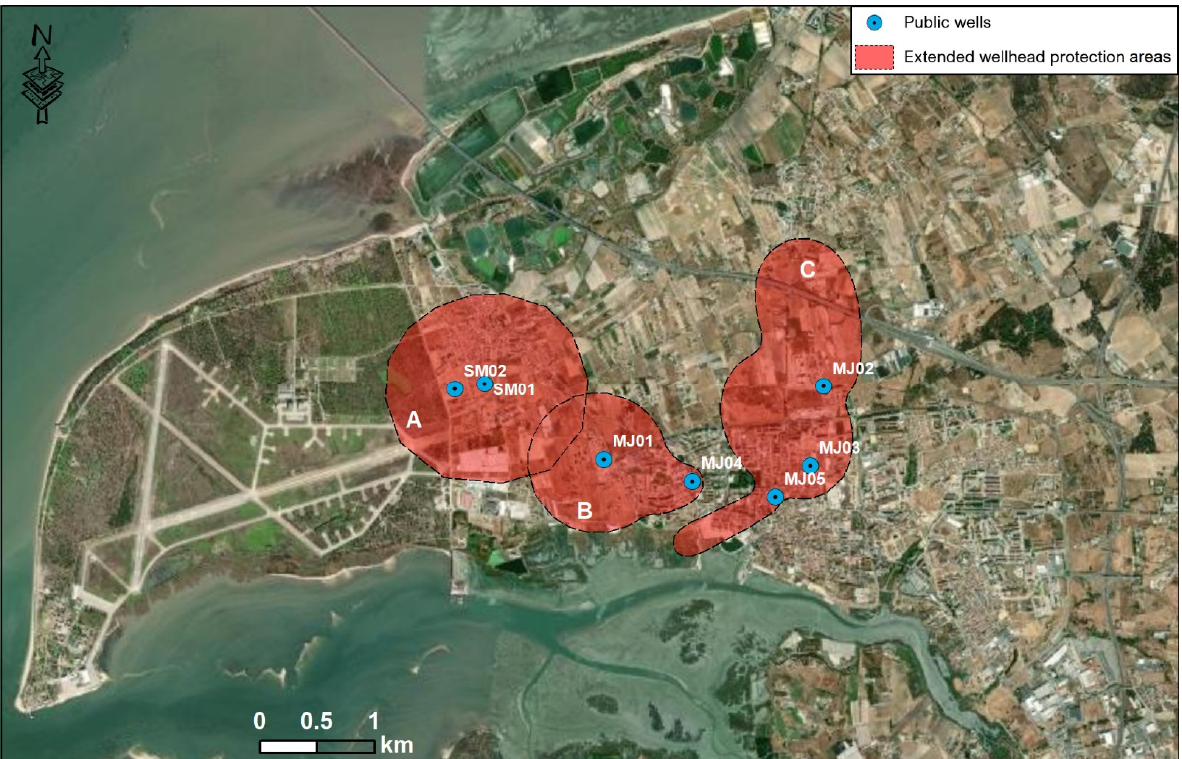
Figure 4. Current extended wellhead protection areas. Table 1. Hydrogeological parameters and wells technical features used in the application of analytical methods to calculate the WPAs in force.